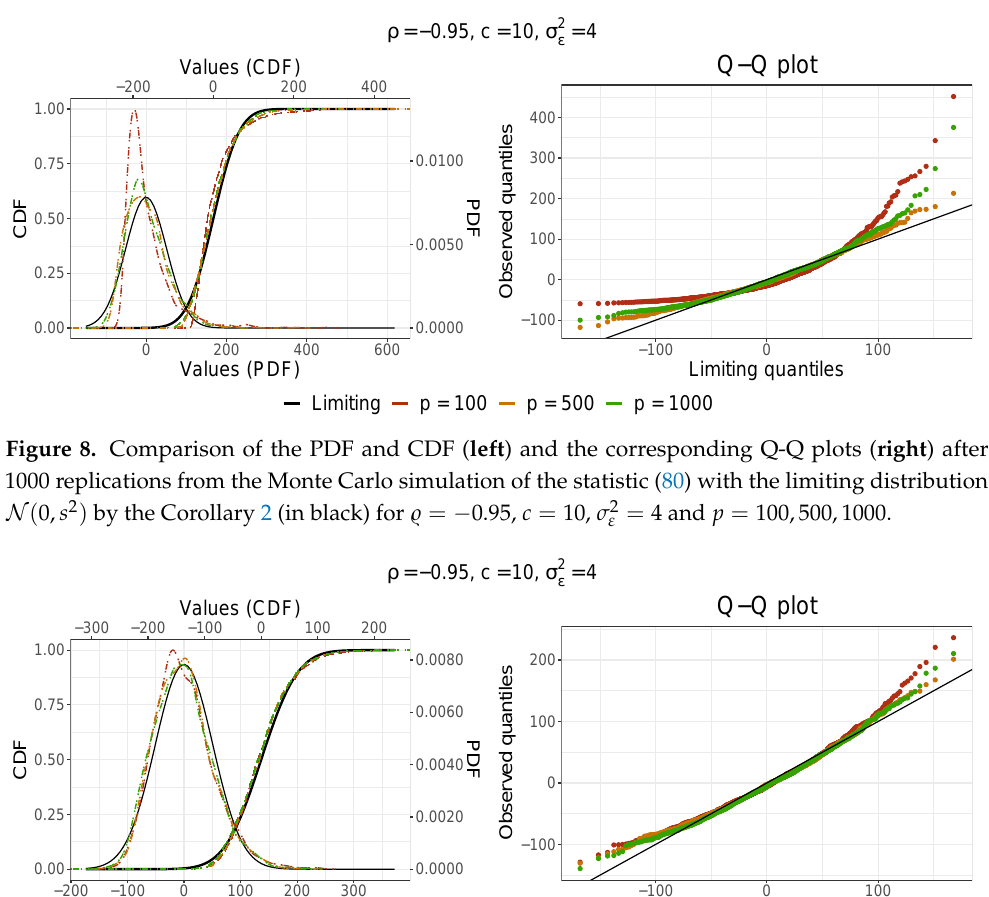
Figure 9. Comparison of the PDF and CDF ( left ) and the corresponding Q-Q plots ( right ) after 1000 replications from the Monte Carlo simulation of the statistic (80) with the limiting distribution N ( 0, s 2 ) by the Corollary 2 (in black) for (cid:36) = − 0.95, c = 10, σ 2